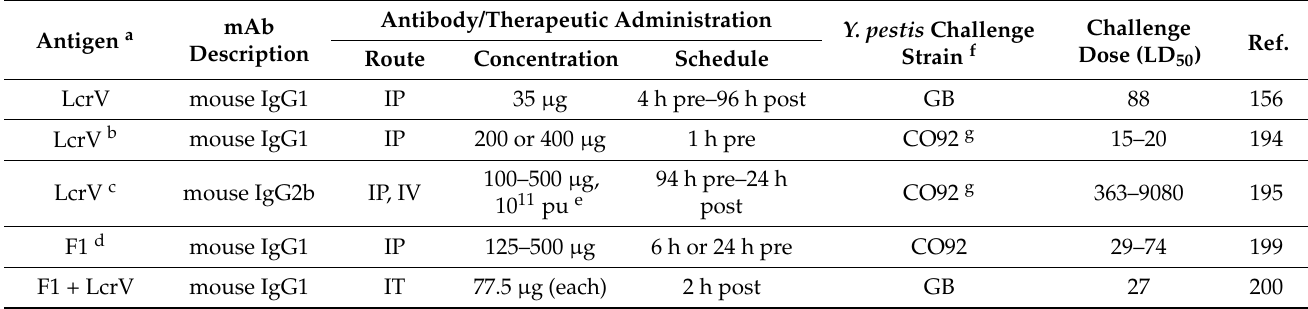
Table 2. Monoclonal antibodies shown to protect mice in pneumonic plague models (intranasal instillation or exposure to aerosolized